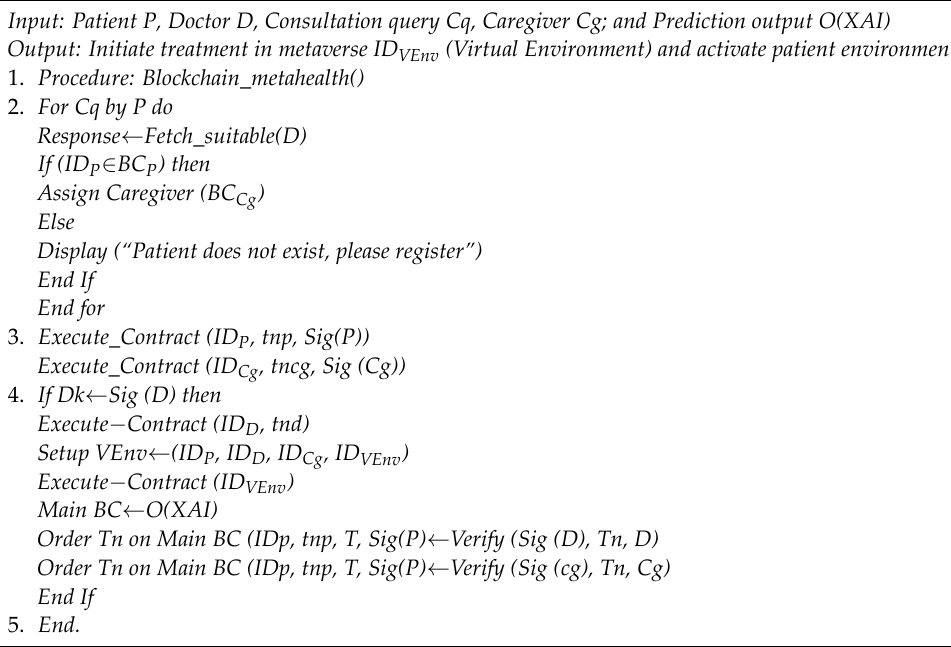
Algorithm 2: Blockchain‑based network for the healthcare